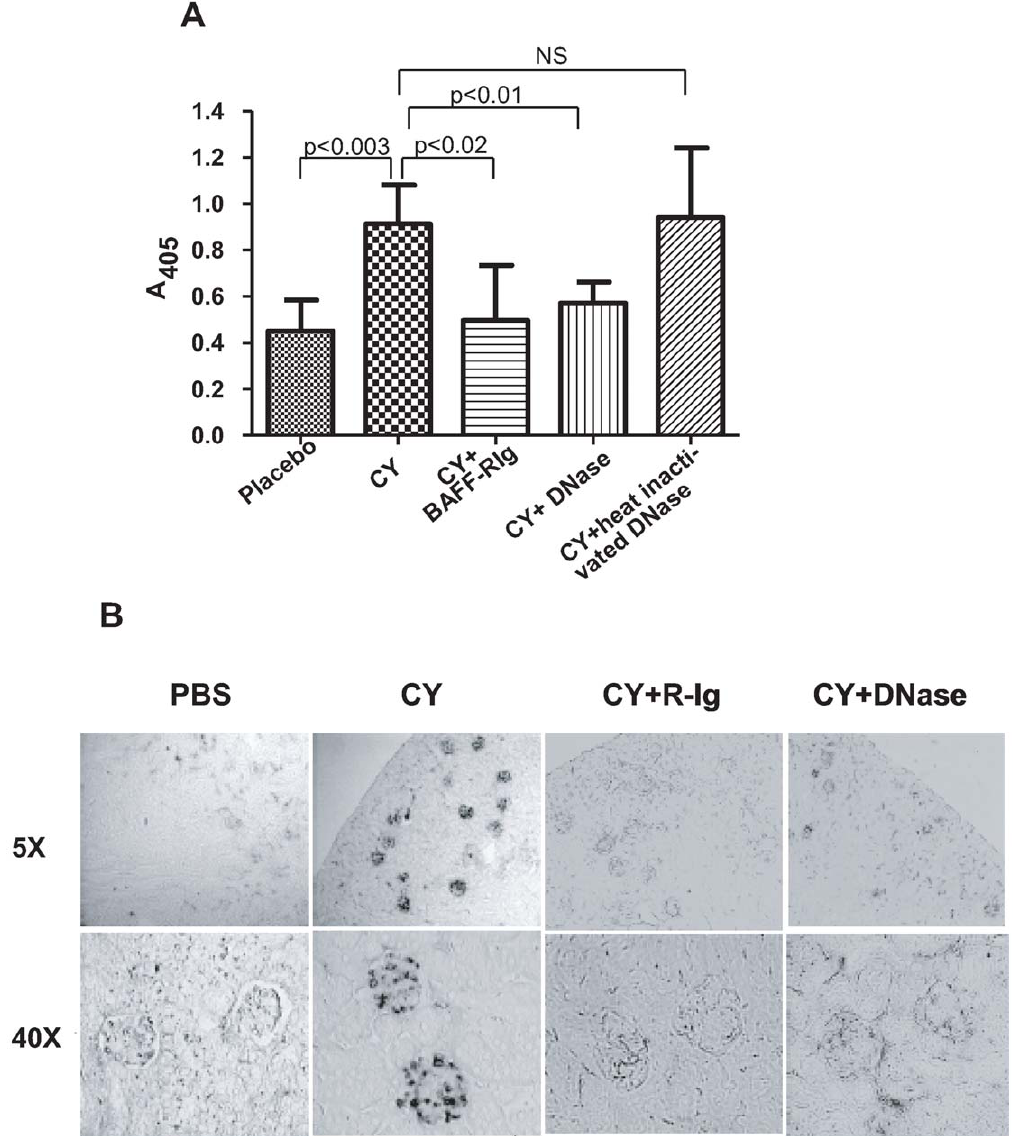
Figure 5. Increase in serum anti-dsDNA antibodies following CY exposure. ( A ) Serum anti-dsDNA antibodies levels in R4A Tg mice following exposure to CY, CY + BAFF-R-Ig, CY + DNase or CY + heat-inactivated DNase (n=5 mice in each group). A significant increase in dsDNA-reactive antibodies was observed in the serum of CY-treated R4A Tg mice (p , 0.003) that was decreased upon treatment wth BAFF-R-Ig (p , 0.02) or with active DNase (p , 0.01) but not with heat-inactivated DNase. The statistical significance between the groups was determined by paired t test. ( B